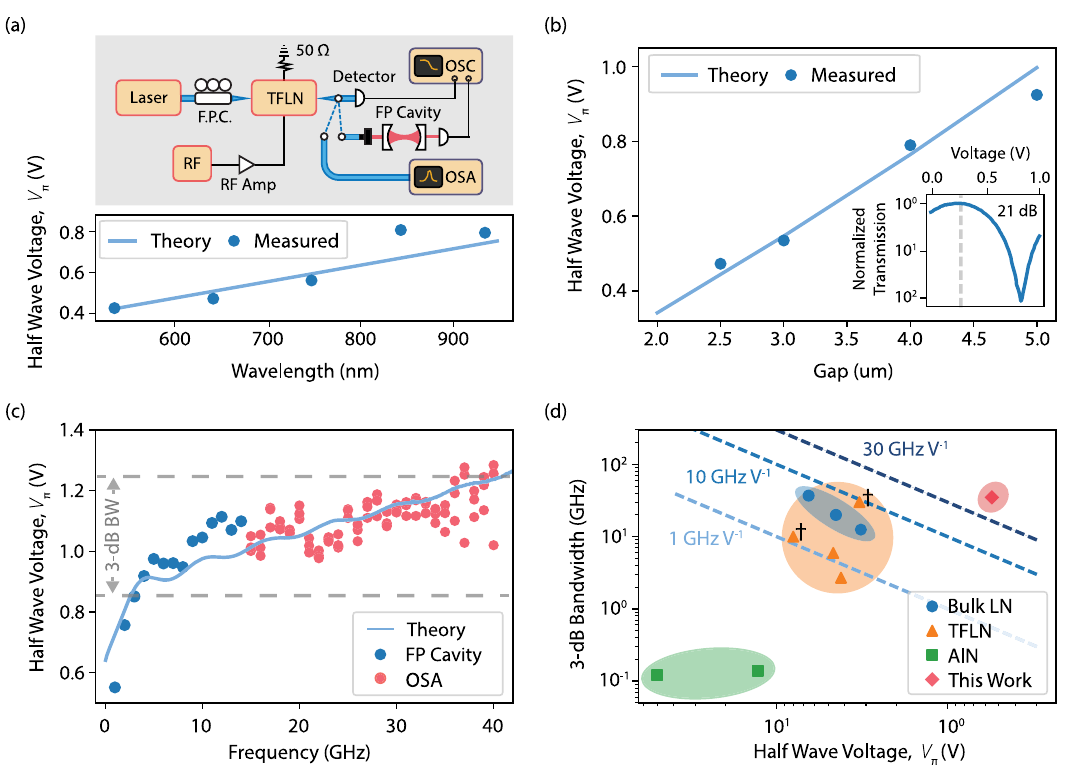
Fig. 2 | Ultra-low V π visible-to-near-infrared wavelength Mach-Zehnder mod- ulators with greater than 35GHz bandwidth. a Experimental setup illustration and measured low-frequency (1MHz) V π for a 1cm MZM with an electrode gap of 3 μ m. Data shown corresponds to V π at λ =532, 638, 738, 838, and 938nm. Simu- lated V π is shown by the solid line. b Simulated and measured V π (1MHz) at λ =738nm for varied electrode gap. Inset shows a measured extinction ratio of ~21dB for a 1cm long, 3 μ m gap modulator. c Frequency dependence of V π for a 1cm long MZM. A 3dB EO bandwidth of~35GHz is extracted from the response. The bandwidth is measured with respect to a low frequency reference, here taken to be 3GHz. The grey dashed-lines denote the 3dB bandwidth w.r.t 3GHz. d Comparisonofmodulator fi gureof merit BW/ V π between this work,